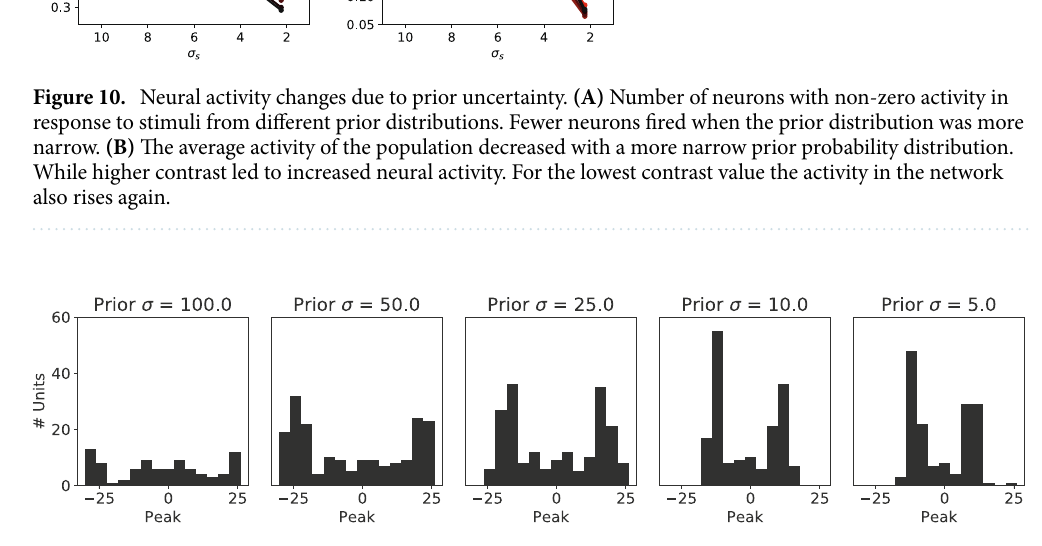
Figure 11. Density of tuning curves does not follow prior probability. A histogram of the peaks of all hidden neuron tuning curves is shown for the different prior conditions. While the distribution of tuning curve peaks becomes denser for the sharper prior (right panel), there is not a direct match with the Gaussian prior probability density. The tuning curve peaks rather concentrate around the flanks of the prior probability distribution.